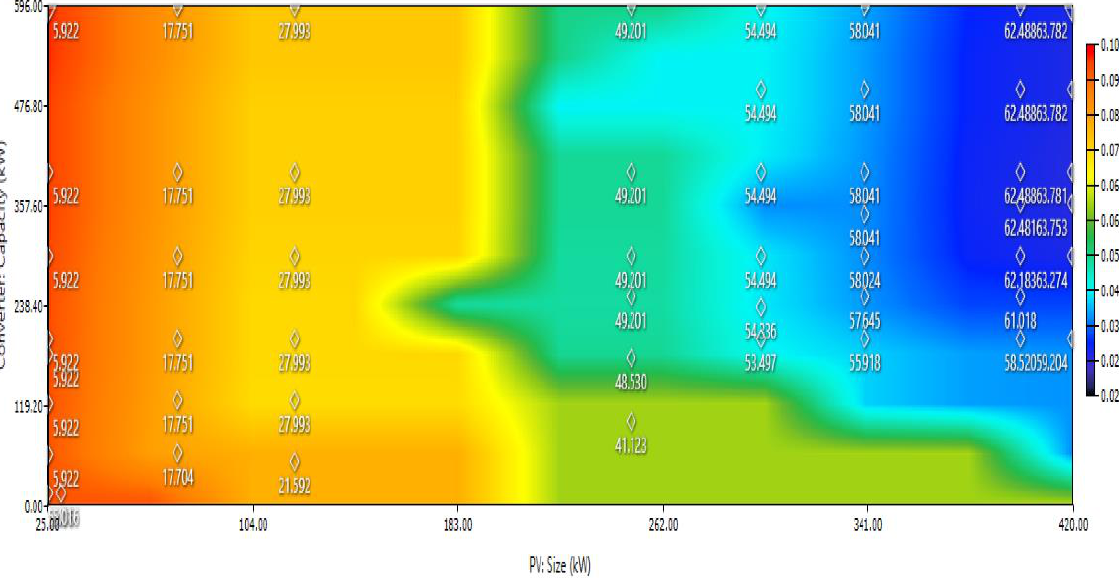
Figure 19. Effects of design parameters on COE and Renewable Fraction.